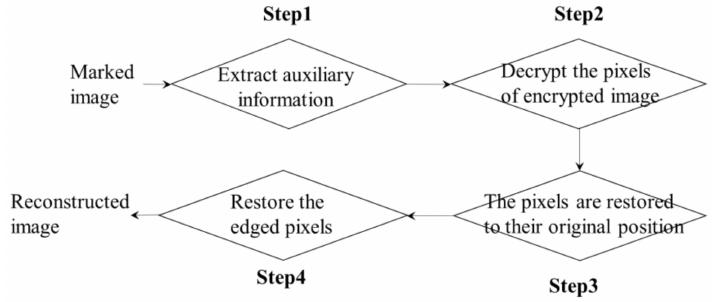
Figure 6. Flow chart of the